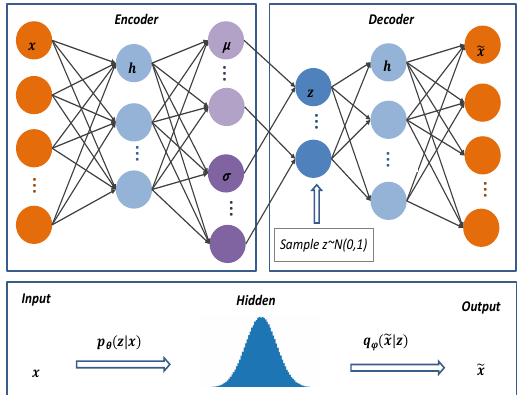
Figure 3. The VAE